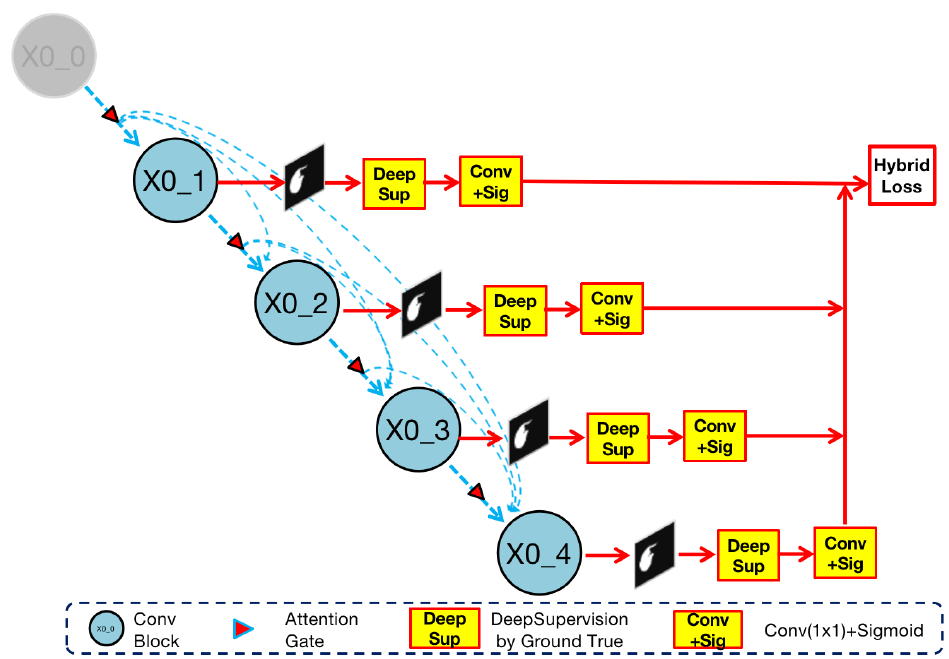
Figure 6. Implementation of deep supervision in Render U-Net. Ground truth supervises the output of the nested convolution structure. The four results X 0_1 , X 0_2 , X 0_3 , X 0_4 are compare with ground truth and directly participate in the calculation of hybrid